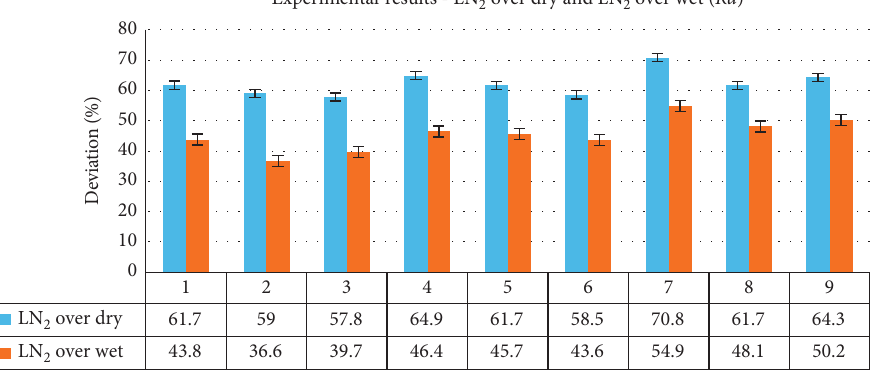
Experimental results - LN 2 over dry and LN 2 over wet ( Ra )